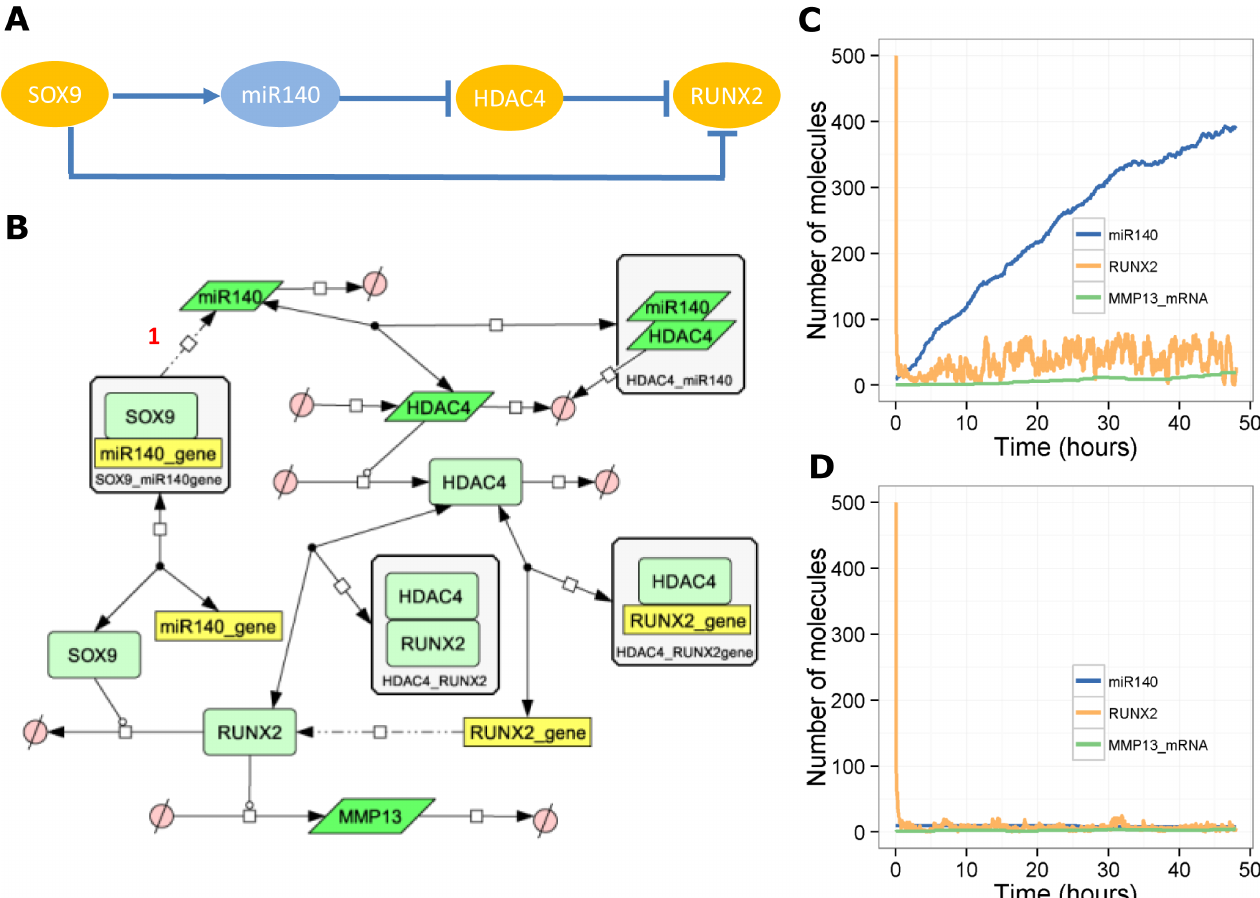
Fig 3. Model of the involvement of miR-140in SOX9-dependent regulation of RUNX2. A , Network motif showingincoherentfeedforward loop. B , Diagramof full model. C - D ,Output from one stochastic simulation, C, with miR-140( k synmiR140 = 0.0018 s -1 ) or D , without miR-140( k synmiR140 = 0.0 s -1